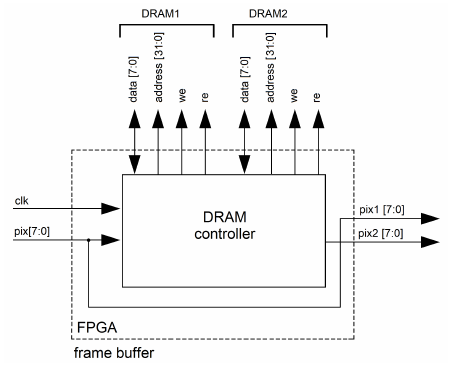
Figure 9. FPGA architecture for the “frame buffer” unit. Two external memories configured in switching mode makes it possible to store the current frame (time t ) into a DRAM configured in write mode, while another DRAM (in read mode) deliver pixel flow for a previous frame (frame at time t −